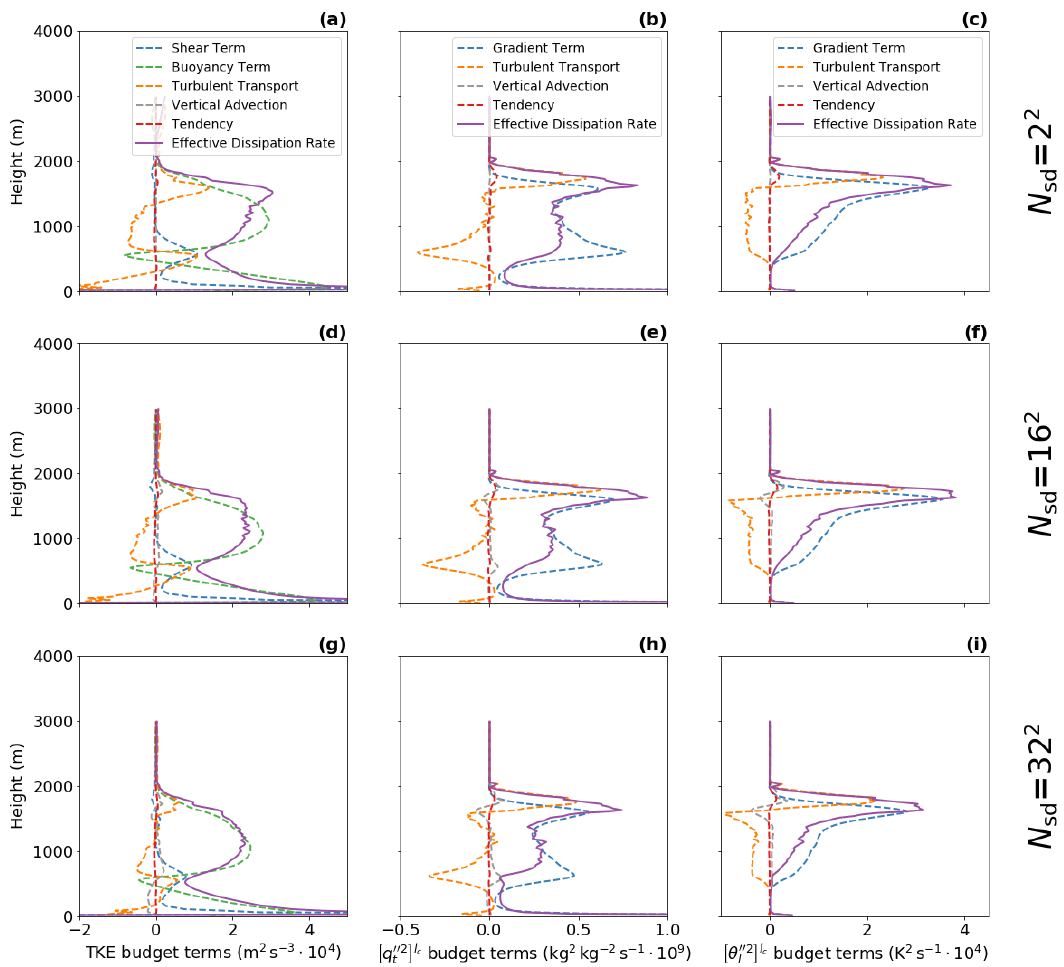
(cid:2) (cid:2) (cid:3) l c (cid:3) l c q (cid:48)(cid:48) 2 θ (cid:48)(cid:48) 2 ( b , e , h ), and ( c , f , i ) (see Equations (6)–(8)) t l